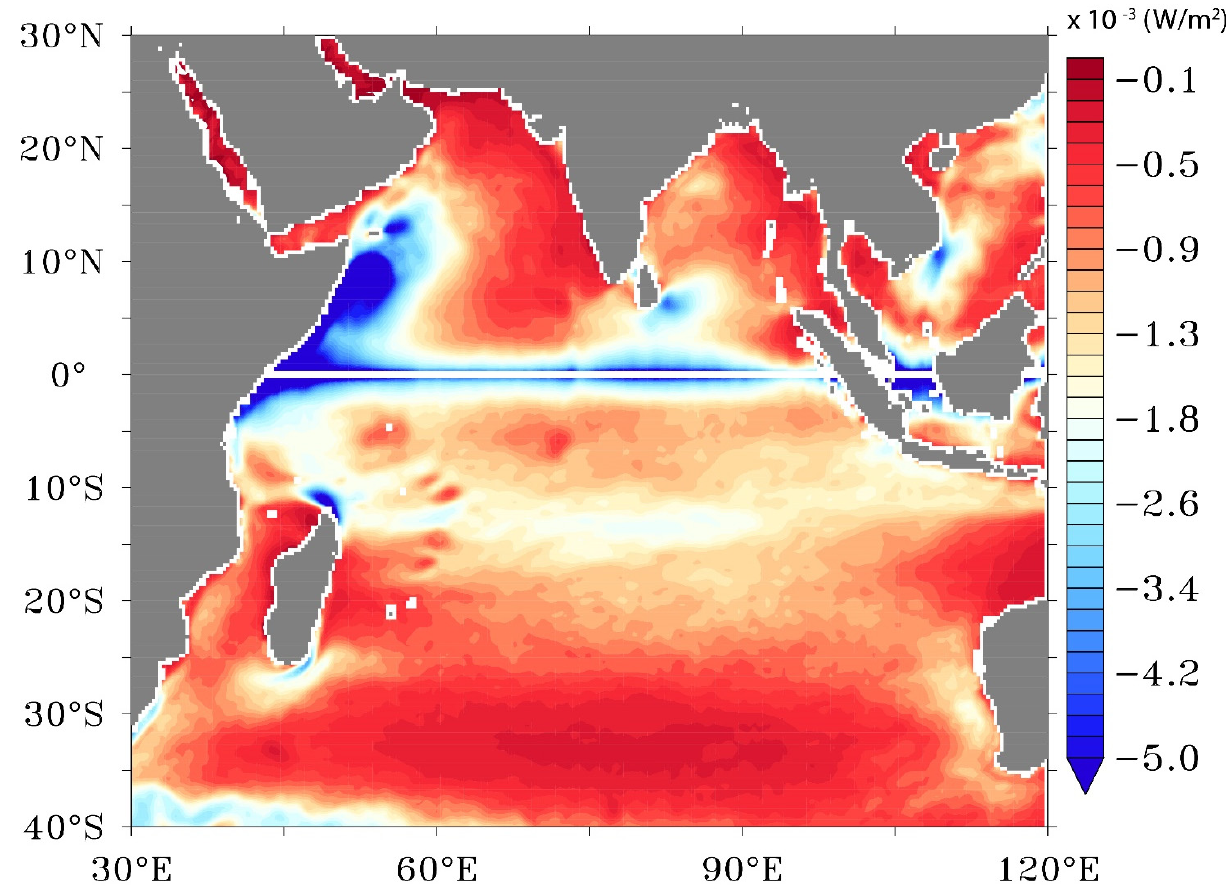
Figure 7. The average difference between ageostrophic wind power ( × 10 − 3 W/m 2 ) estimated with and without the surface currents during 2007–2020.